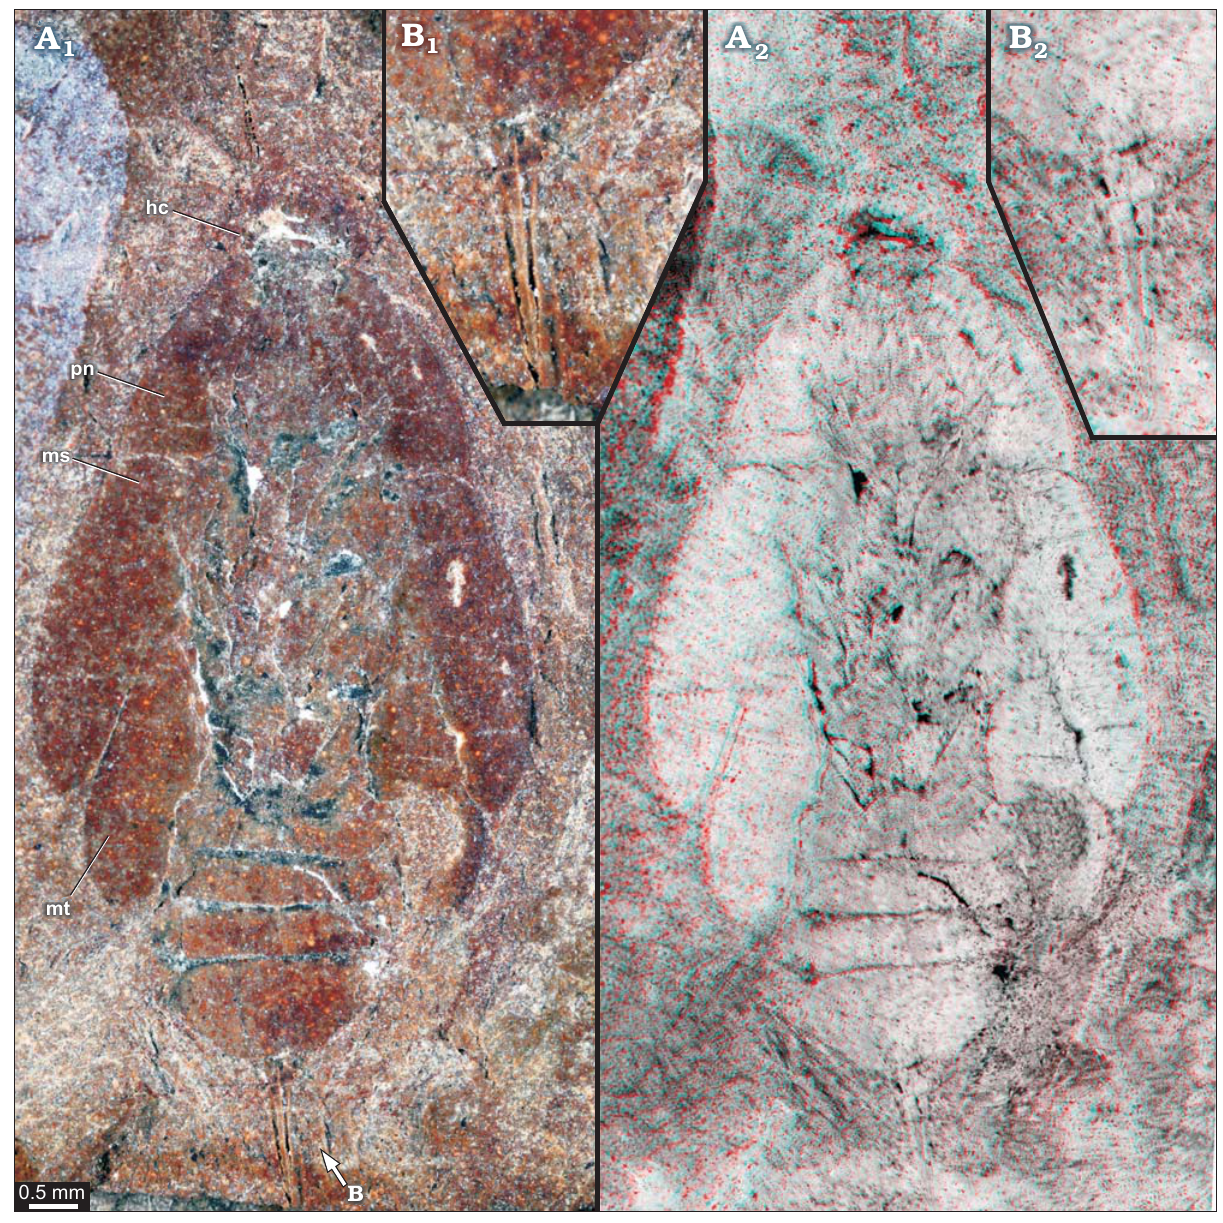
Fig. 3. Roachoid nymph YPM IP 000057 from the Carboniferous Carbondale Formation of Mazon Creek, USA; in ventral view. Overview ( A ) and close-up images of ovipositor ( B ); A 1 , B 1 , photographs without stereo information; A 2 , B 2 , red-cyan stereo-anaglyphs (please use red-cyan glasses to view). Abbreviations: hc, head capsule; ms, tergite of mesothorax; mt, tergite of metathorax; pn, tergite of